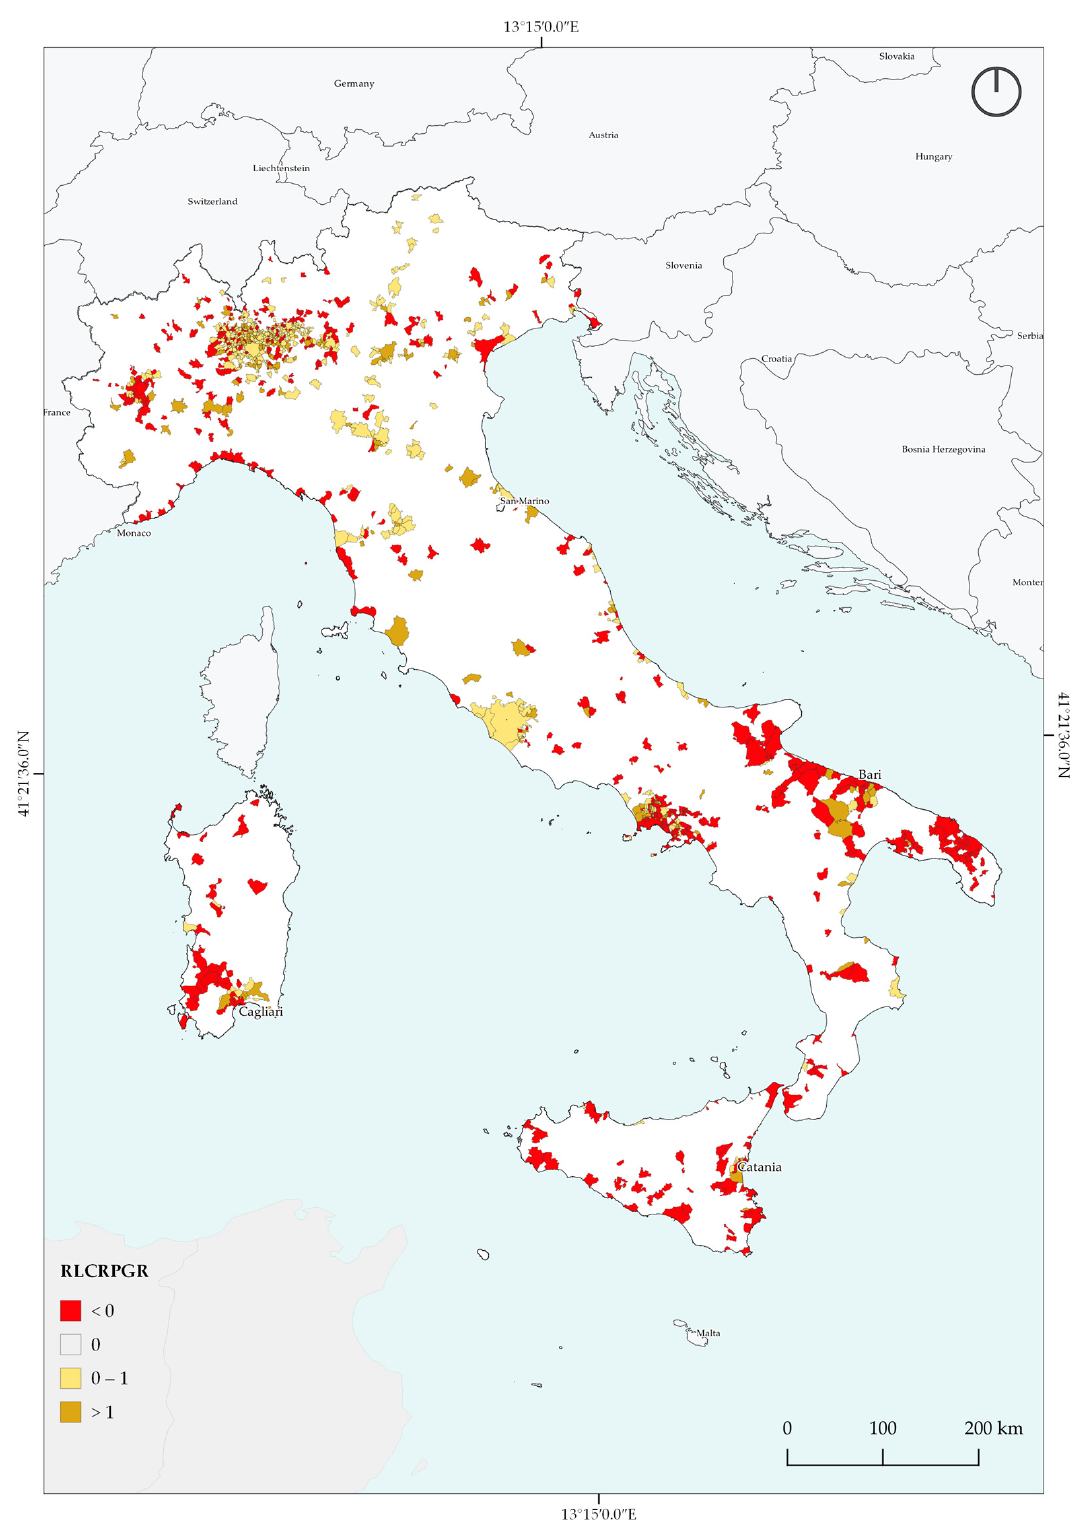
Figure 8. RLCRPGR values in the municipalities classified as “Urban Center”, “Dense Urban Cluster”, and “Semi-dense Urban Cluster” with an increase in land consumption (LCR > 0). In 51.3% of these municipalities, the population decreases, while in the remaining ones, the population increases together with land consumption.